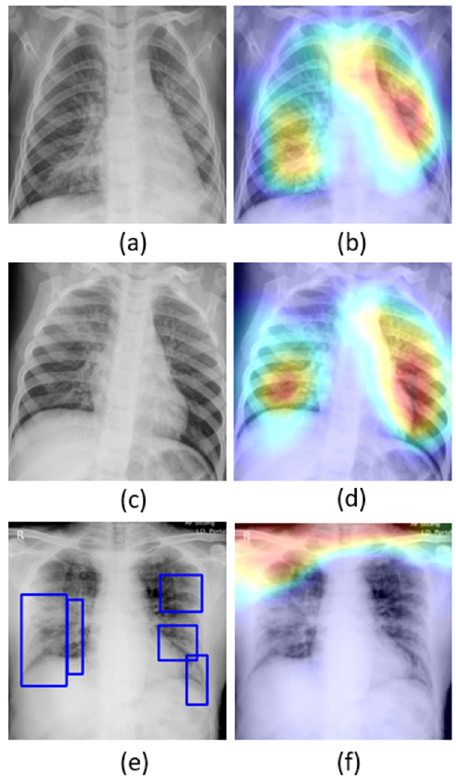
Figure 5. Original CXRs and their salient ROI visualization: ( a ) and ( b ) show a CXR with bilateral bacterial pneumonia and the corresponding Grad-CAM visualization; ( c ) and ( d ) show a CXR with viral pneumonia manifestations and the corresponding salient ROI visualization; and ( e ) and ( f ) show a sample CXR from the Montreal-COVID-19 CXR collection with ground truth (GT) annotations and corresponding salient ROI visualization. Blue frames in ( e ) denote radiologist annotations indicating disease regions, which serve as ground truth in our analysis.